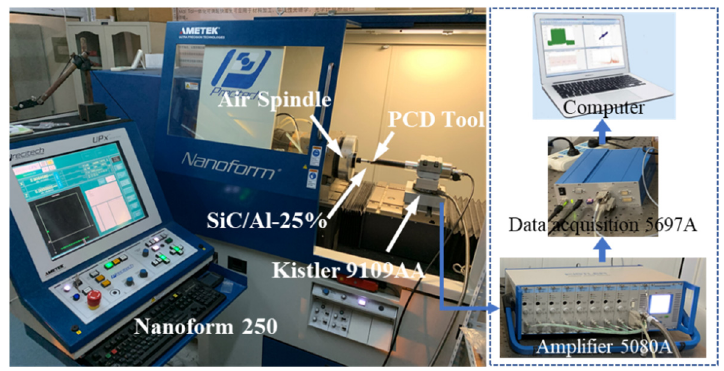
Figure 5. Experimental setup.